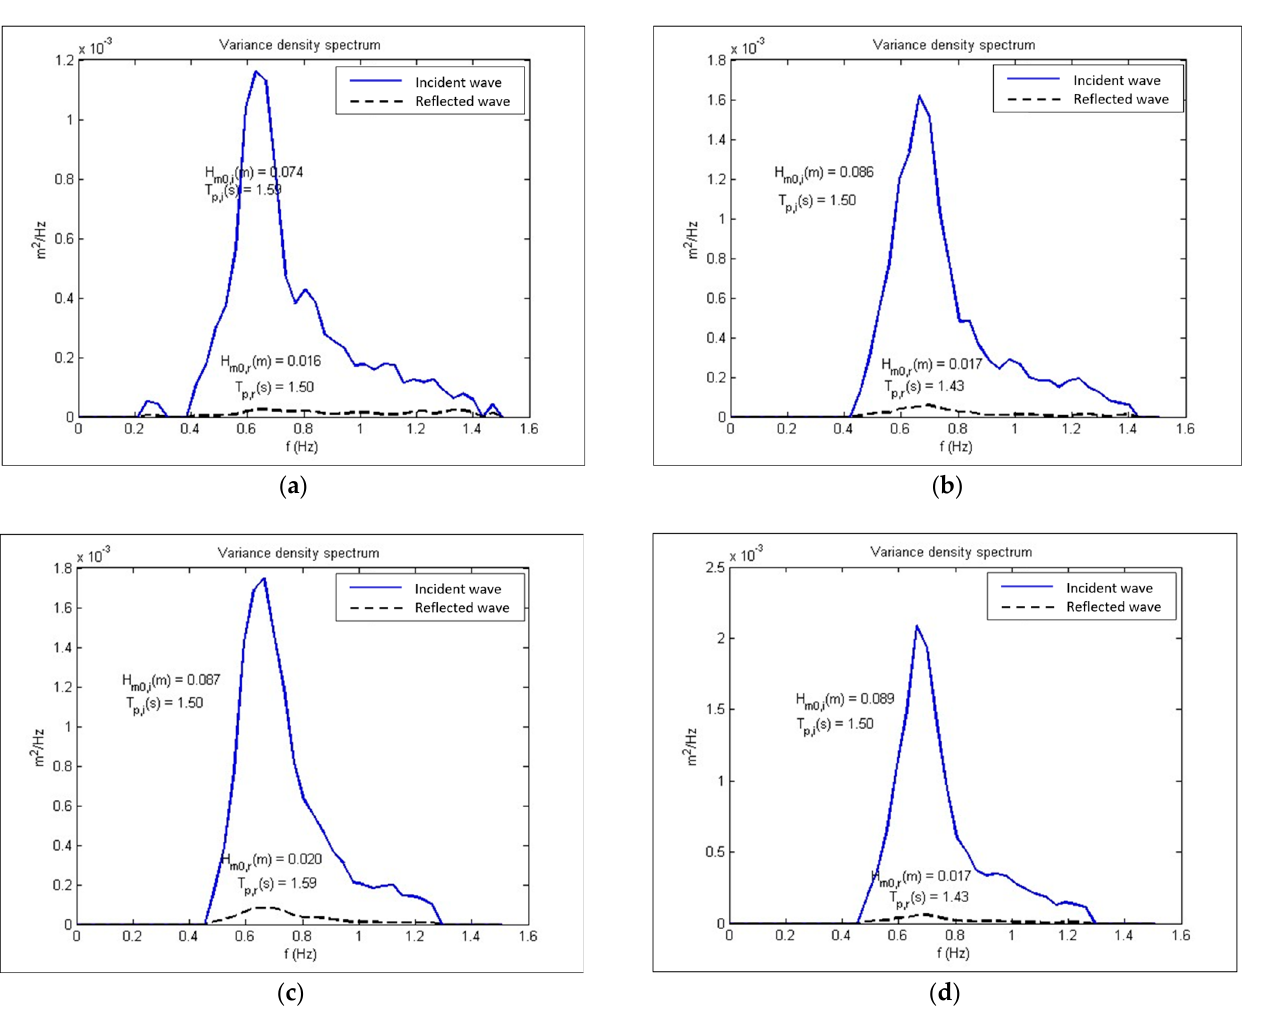
Figure 15. Influence of the crest freeboard on the wave reflection coefficient K r . The relationship between K r and R c / H m0 is shown in Figure 16. When R c / H m0 = − 1, i.e., in the emerging state, the wave reflection coefficients converge for all breakwaters with K r = 0.1–0.2. When the breakwaters work in an emerging state ( R c > 0), the proposed PTPWB produced the smallest reflection wave coefficient of K r = 0.20–0.25. Next is the rubble mound with K r = 0.26–0.28; the HTB with K r = 0.35–0.47; and the PRBW with K r =